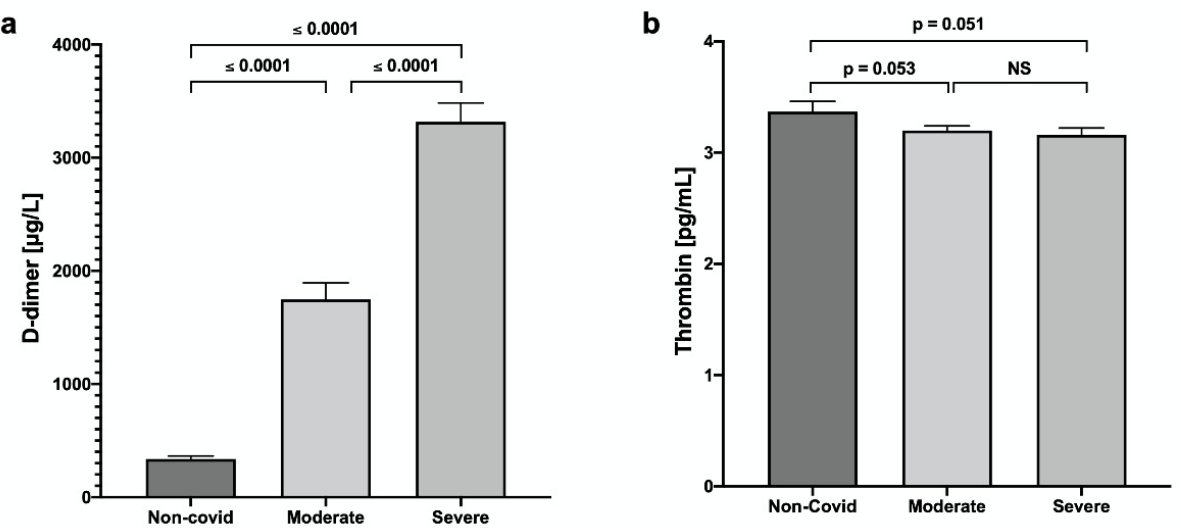
Figure 1. Evaluation of serum concentrations of ( a ) D-dimer and ( b ) thrombin in patients with COVID-19. Values are expressed as mean ± SE.